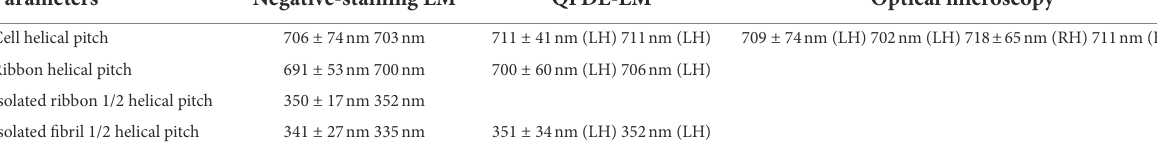
TABLE 1 Dimensions of the cell and